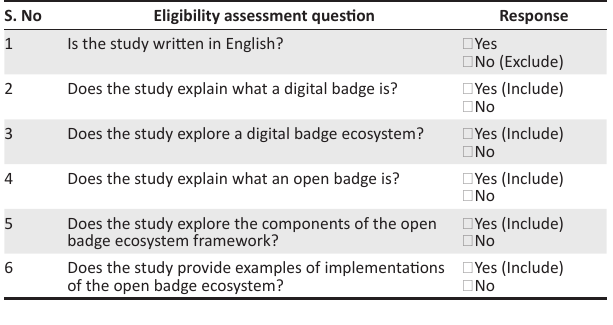
TABLE 4: Eligibility assessment questions.